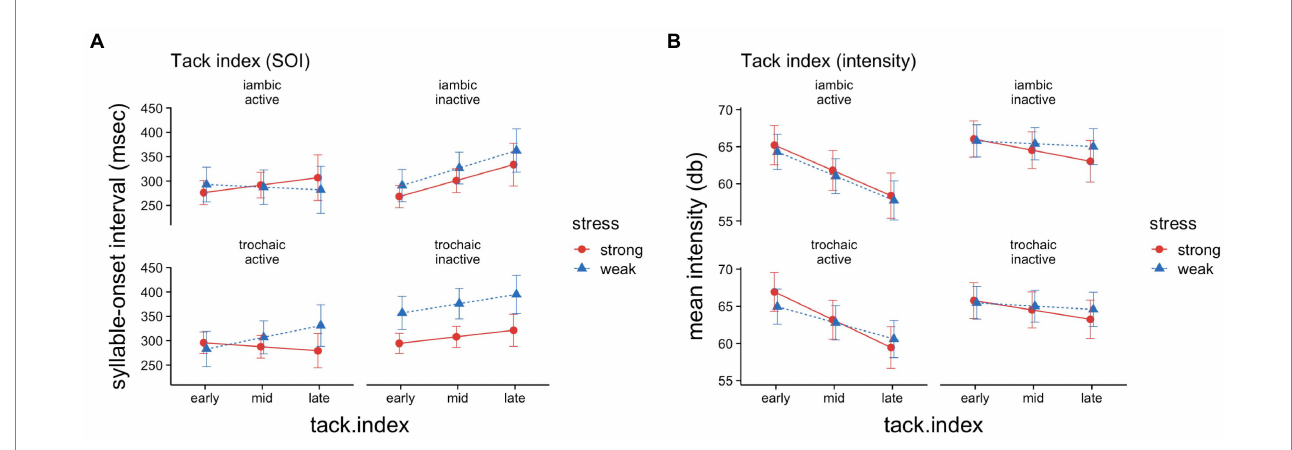
FIGURE 2 Syllable-onset intervals (A) and syllable intensities (B) for tack syllables, as a function of stress (strong vs. weak), meter (iambic vs. trochaic), musical activity (active vs. not active), and tack index (small ~0, mid, large ~5). The whiskers depict 95% confidence